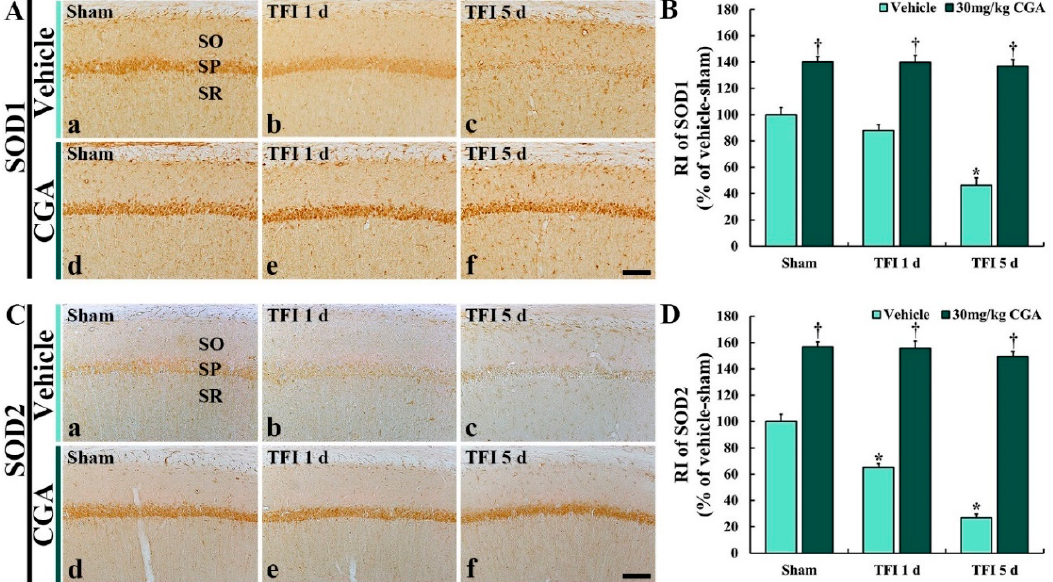
Figure 5. Immunohistochemistry for SOD1 ( A ) and SOD2 ( B ) of the vehicle/sham ( A ( a ), C ( a )), CGA/sham ( A ( d ), C ( d )), vehicle/TFI ( A ( b , c ), C ( c , d )) and CGA/TFI ( A ( e , f ), C ( e , f )) groups at 1 and 5 days after TFI. In the vehicle/sham group, SODs immunoreactivities are found in CA1 pyramidal cells, and SODs immunoreactivities in the vehicle/TFI group are decreased with time after TFI. However, SODs immunoreactivities in the CGA/sham group are significantly higher than those in the vehicle/sham group, and they are maintained after TFI. Scale bar = 40 μ m. ( C , D ): RI of SOD1 ( C ) and SOD2, respectively, in the CA1 SP. The bars indicate the means ± SEM ( n = 7 at each point in time, * p < 0.05 vs. the vehicle/sham group, † p < 0.05 vs. the corresponding time point vehicle group).